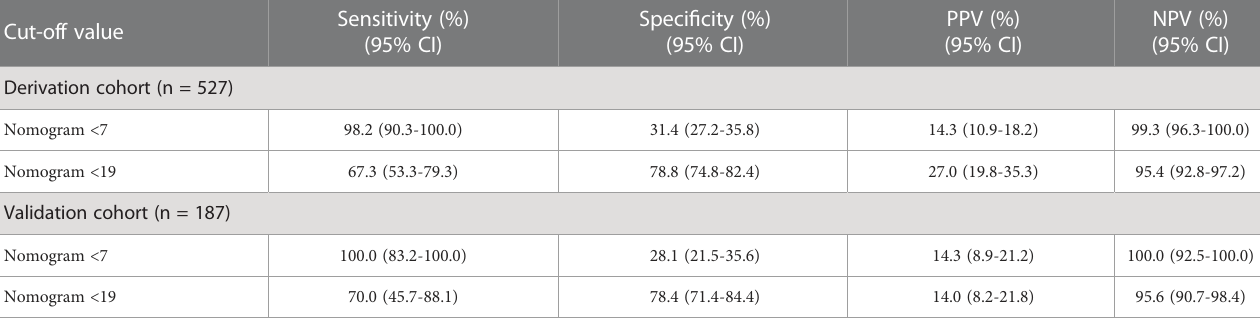
TABLE 2 Sensitivity, speci fi city, and predictive values of the nomogram classi fi cation determined by the 25th and 75th percentiles of the score distribution.